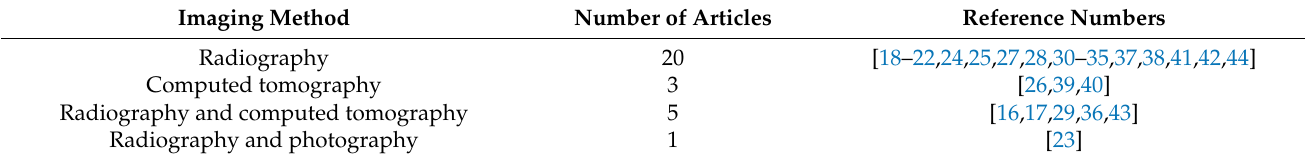
Table 2. Classification of the included articles, according to the imaging